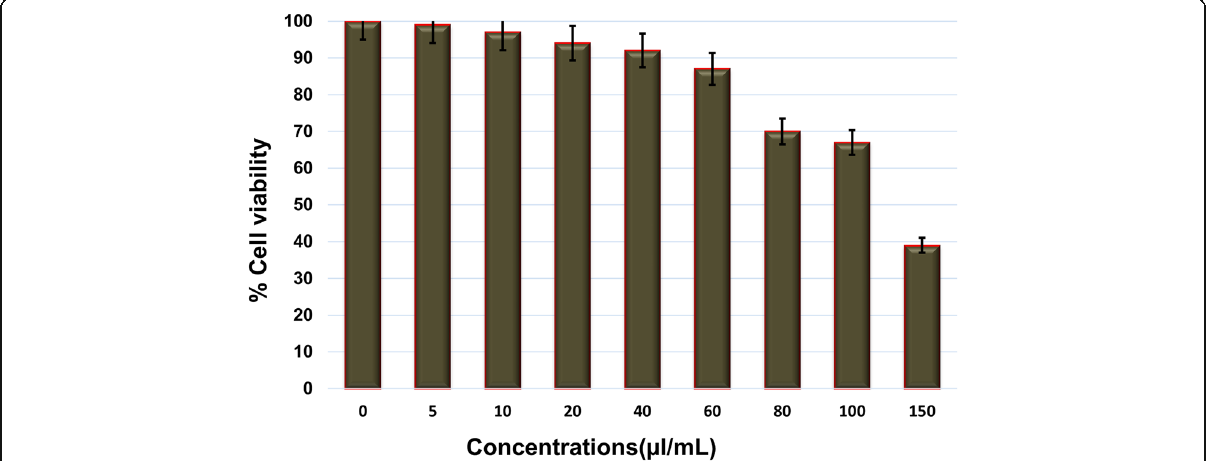
Fig. 5 Safe and toxic dose determination of crude microcystins for 3 T3 cells by MTT assay. Viability of 3 T3-L1 cells under the treatment of various concentrations of microcystins. Data are expressed as means of values ± SEM. Data are statistically significant at P <